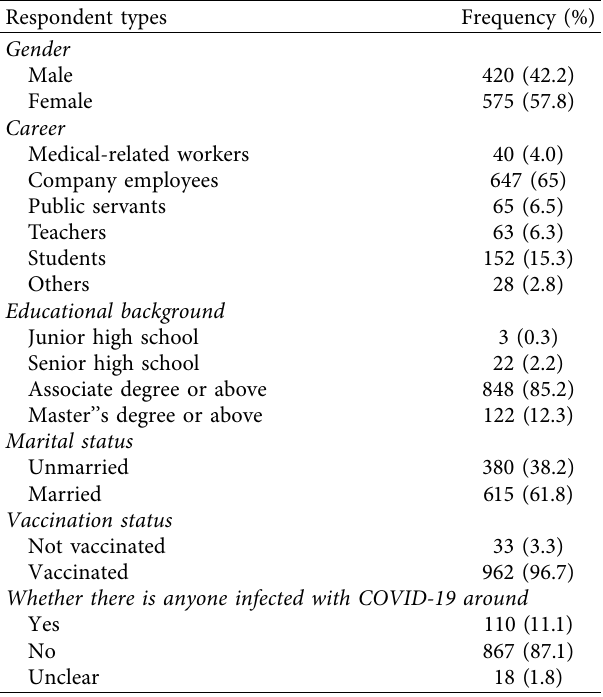
Table 1: Demographic statistics data of the respondents ( n �